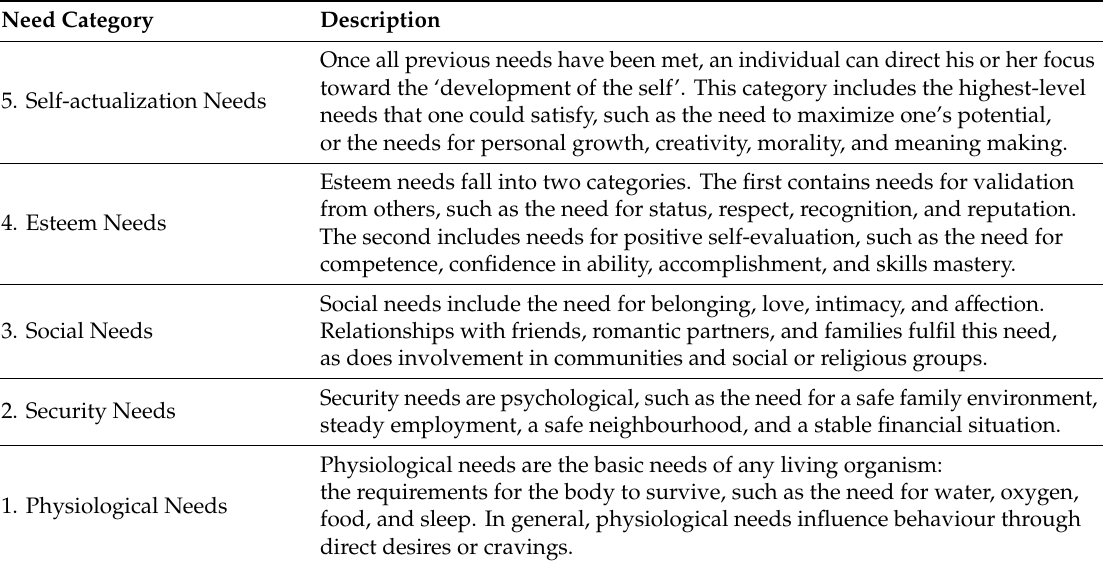
Table 1. The five need categories in Maslow’s Hierarchy of Needs.